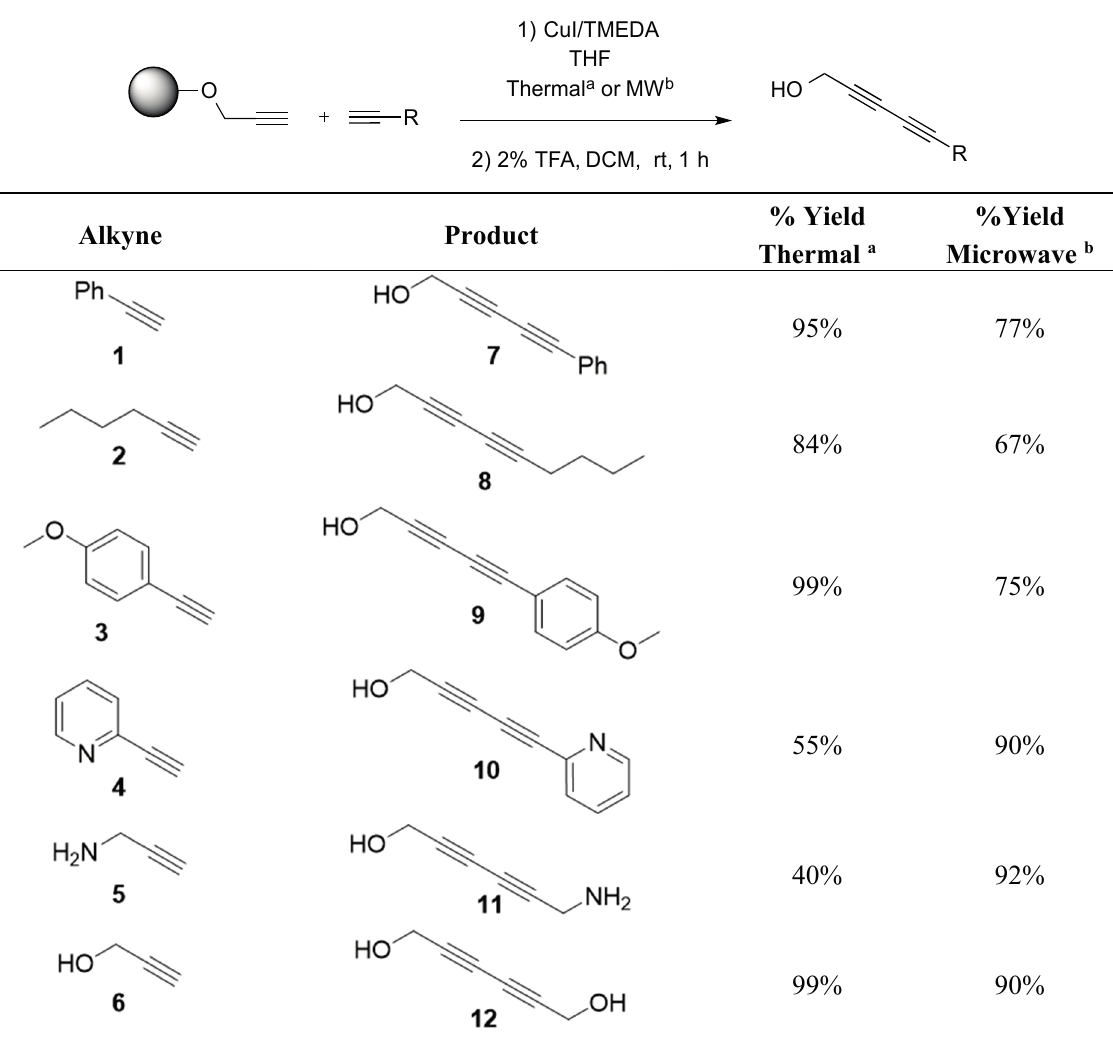
Table 2. Propargyl Alcohol Derivatized Resin Glaser-Hay